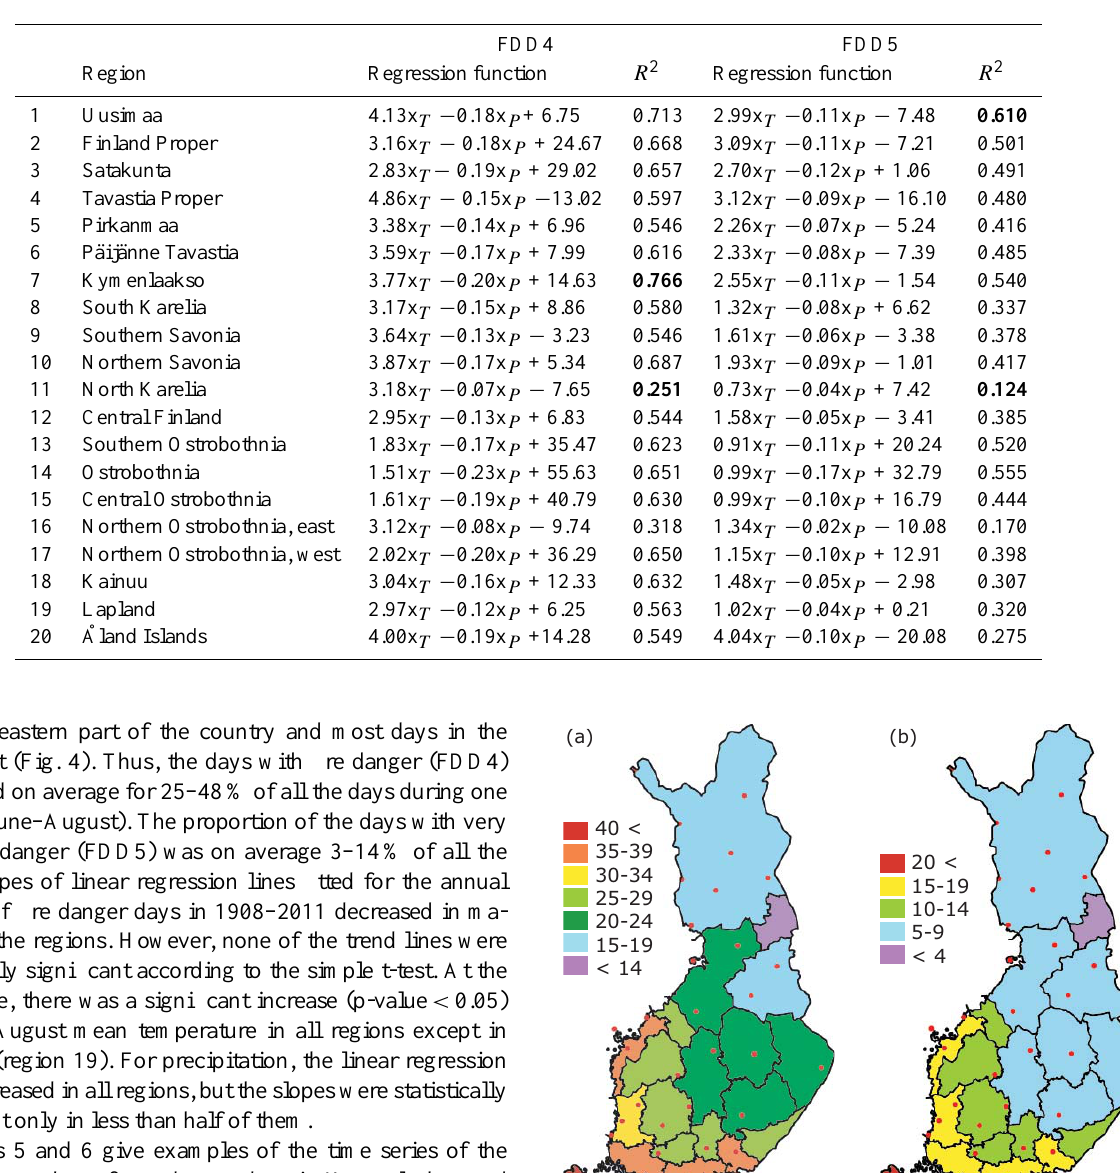
Table 3. The linear multi-regression functions and the coefficients of determination ( R 2 ) for FDD4 and FDD5 for each of the regions. Minimum and maximum values of R 2 are in bold.